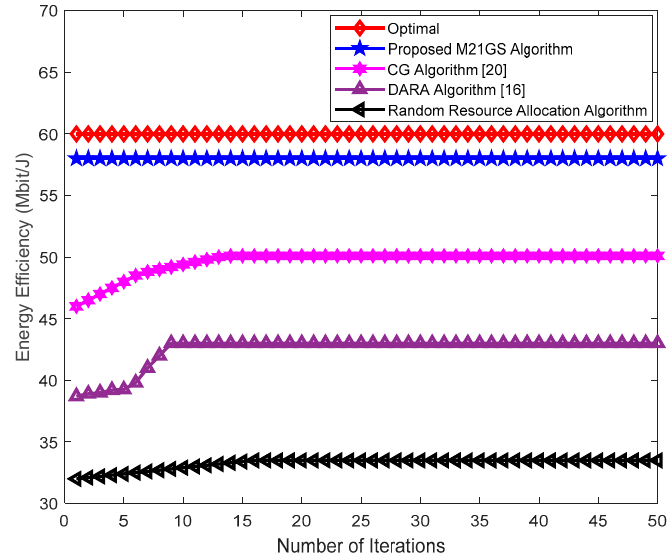
Figure 7. Comparison of the energy efficiency under different number of iterations.